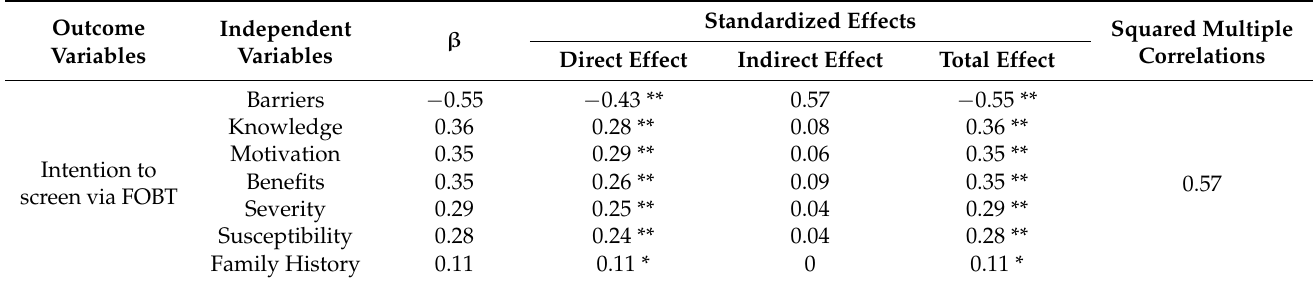
Table 4. Direct, indirect, and total effects of variables in the modified stable prediction model (N =